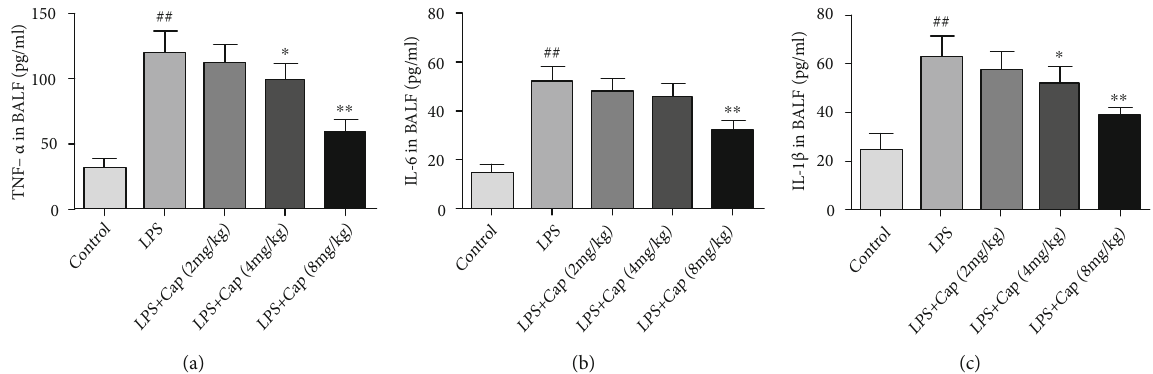
Figure 7: Cap inhibits the release of proin fl ammatory cytokines in neonatal rats with acute lung injury. The levels of TNF- α (a), IL-6 (b), and IL-1 β (c) in BALF. Results are expressed as the mean ± standard deviation ( n = 8 ). ## P < 0 : 01 compared to the control group; ∗ P < 0 : 05 and ∗∗ P < 0 : 01 compared to the LPS group.